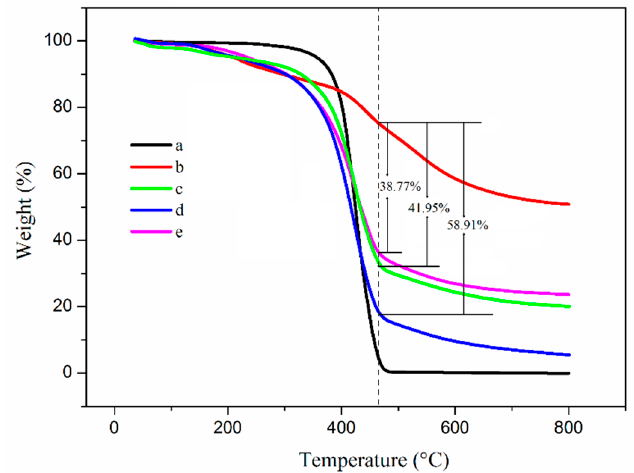
Figure 5. TGA curves of ( a ) TO, ( b ) shell, and TO-loaded microcapsules with core / shell ratios of ( c ) 2:1, ( d ) 3:1, and ( e )